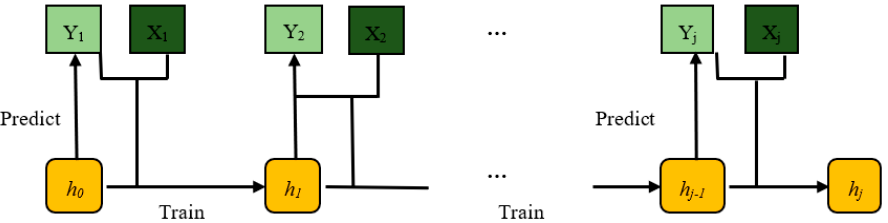
Figure 2. Online learning scheme.